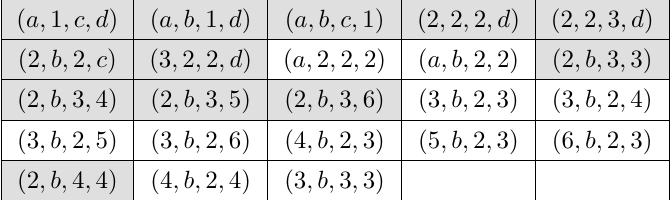
Table 17 . Infinite sequences of type XIII singularities. The gray entries are either reducible to previous types or have at least one of b, c, d = 1 , which gives trivial 1-form symmetry. This table is adapted from